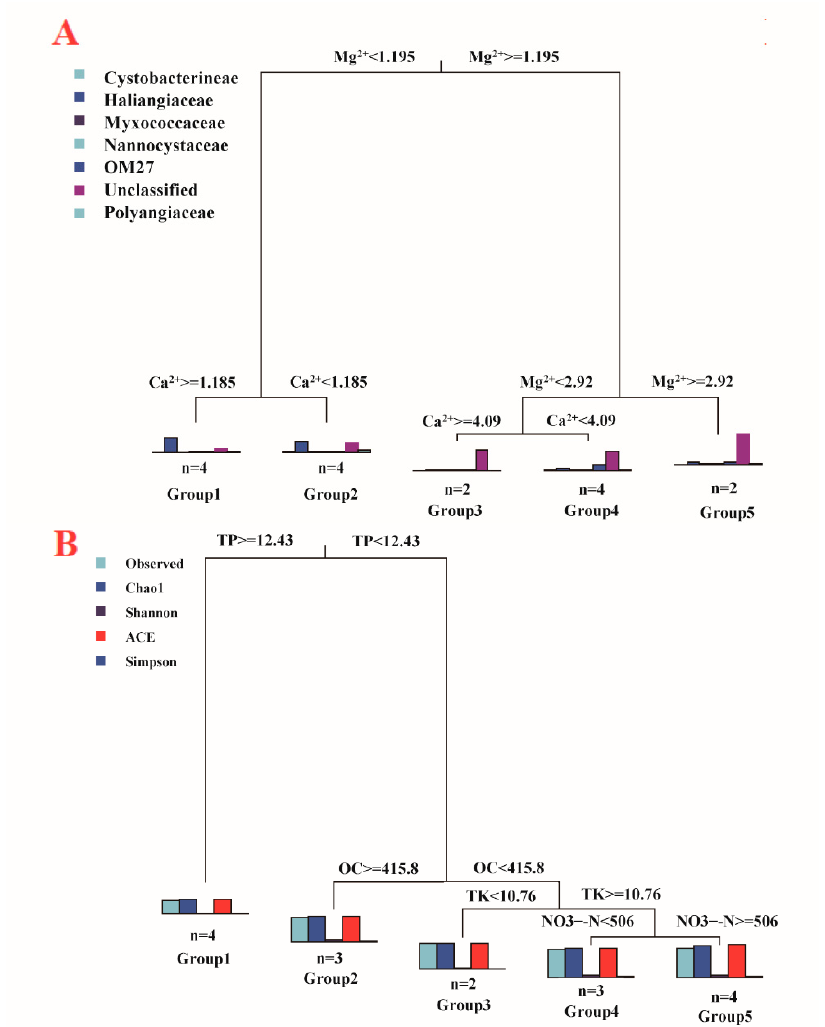
Figure 5. Multivariate regression tree (MRT) analysis of the correlation between myxobacteria composition ( A ) and diversity ( B ), and environmental factors. ( A ): The bar plots illustrate the relative abundance of each order, and the bar plots represent the community composition dynamics among the splits. ( B ): Diversity indices, including Observed OTU richness, Chao1, Shannon, ACE, and Simpson index, standardized for MRT analysis. Bar plots show the multivariate means of diversity among each split. The numbers under the bar are the numbers of samples in each group. TP: total phosphorus, OC: organic carbon, TK: total potassium, NO 3 − -N: nitrate nitrogen.